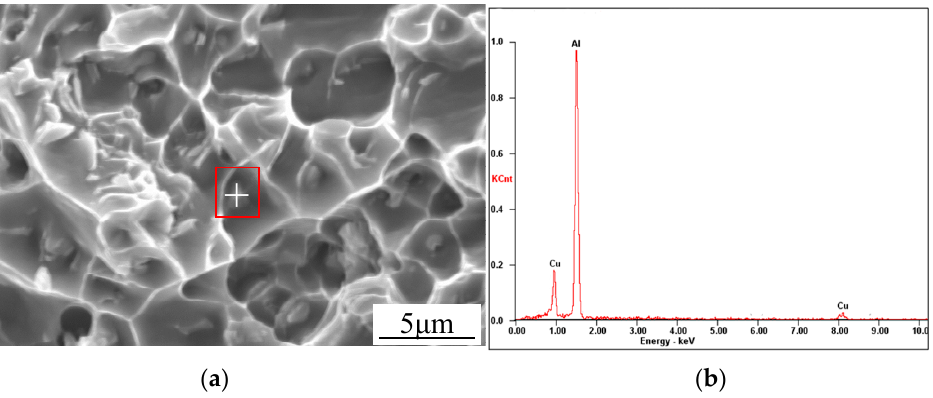
Figure 15. ( a ) Fracture surface morphology of the PCALW welded joint; and ( b ) EDS results of the particle.